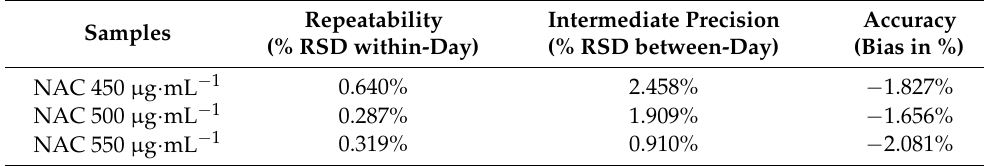
Table 1. Repeatability, intermediate precision, and accuracy.